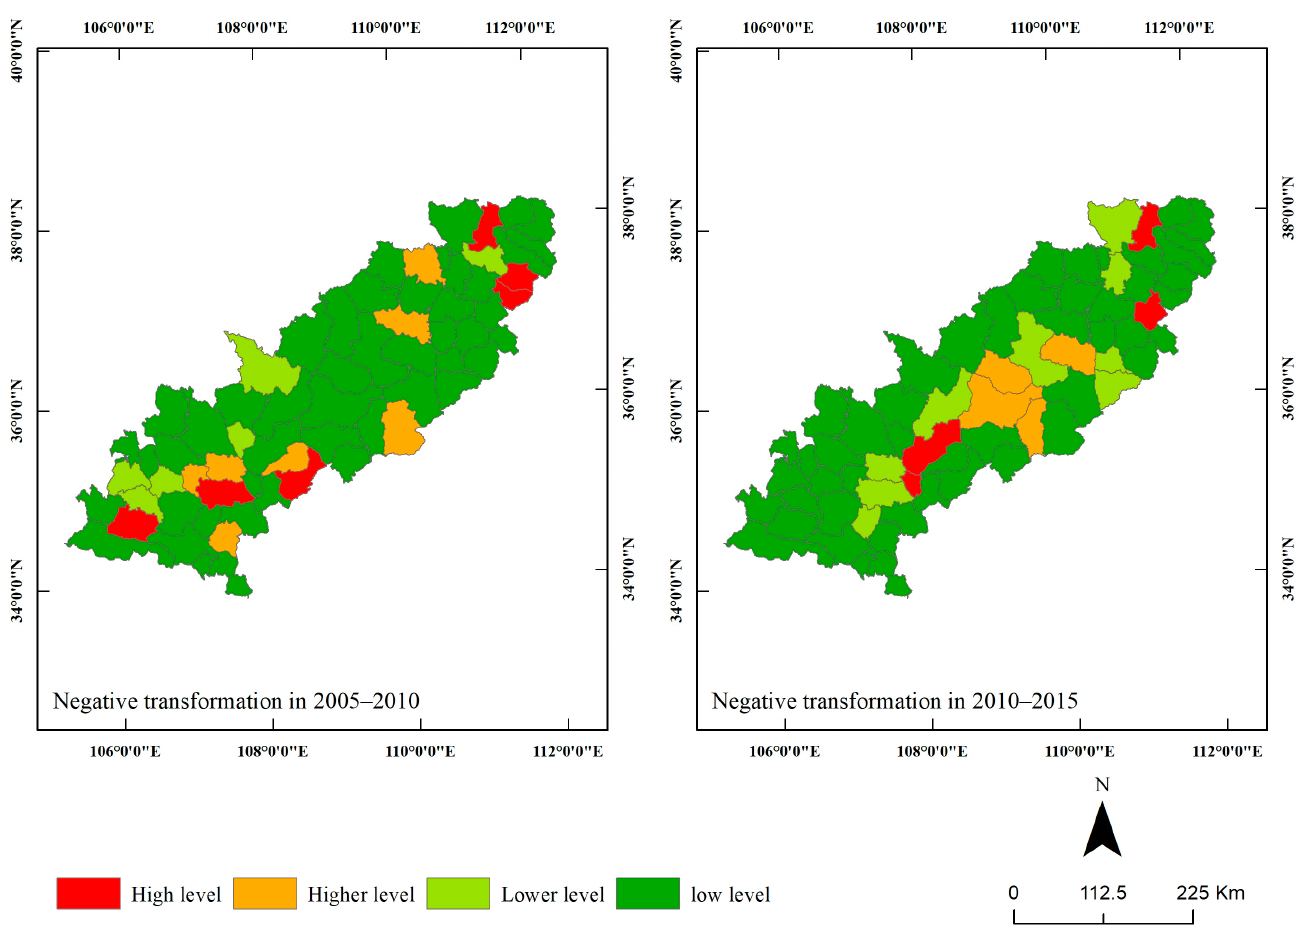
Figure 4. Distribution of transformation rate in the Loess Plateau Ecological Screen in 2005–2010, 2010–2015.